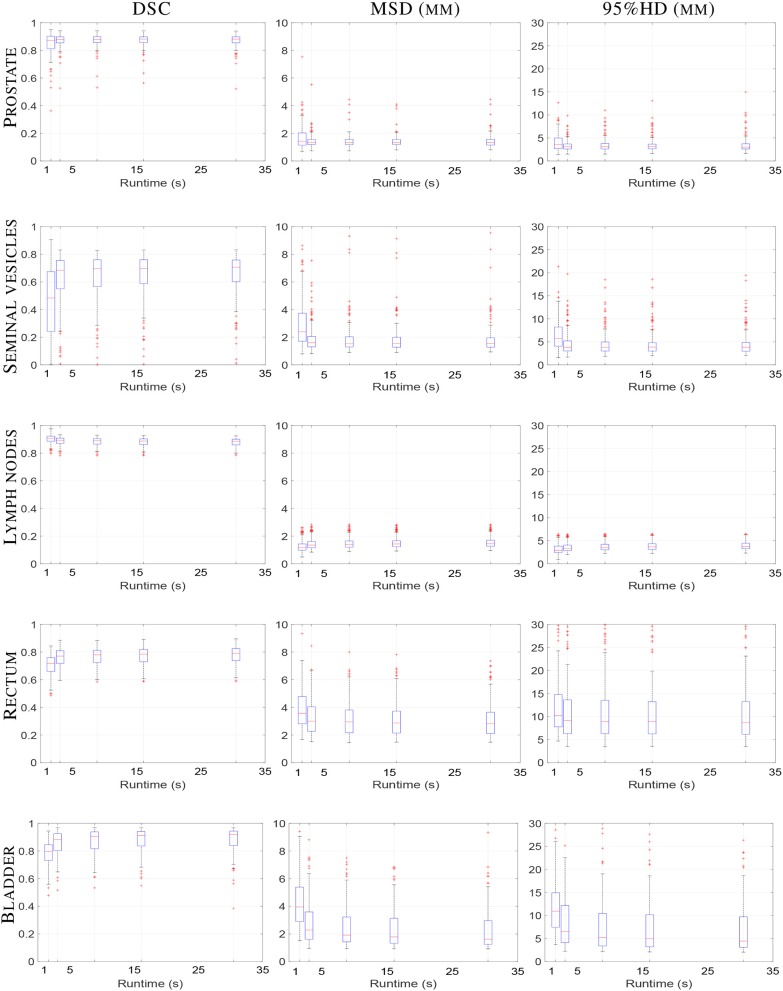
Boxplot of elastix registration performance against runtime in seconds. From left column to right column the DSC (unit-less), MSD (mm) and 95%HD (mm) are shown, respectively. From top to bottom the prostate, seminal vesicles, lymph nodes, rectum and bladder are shown, respectively. Within one boxplot, from left to right the affine registration and B-spline registrations with 100, 500, 1,000, and 2,000 iterations are shown, respectively. Each boxplot contains results of 159 registrations.